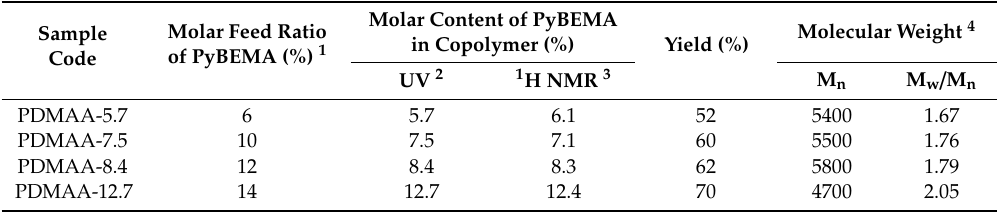
Table1. Copolymerization ofdimethylacrylamide (DMAA) withpyrenebutanoyloxy ethylmethacrylate Table 1. Copolymerization of dimethylacrylamide (DMAA) with pyrenebutanoyloxy ethyl methacrylate (PyBEMA).